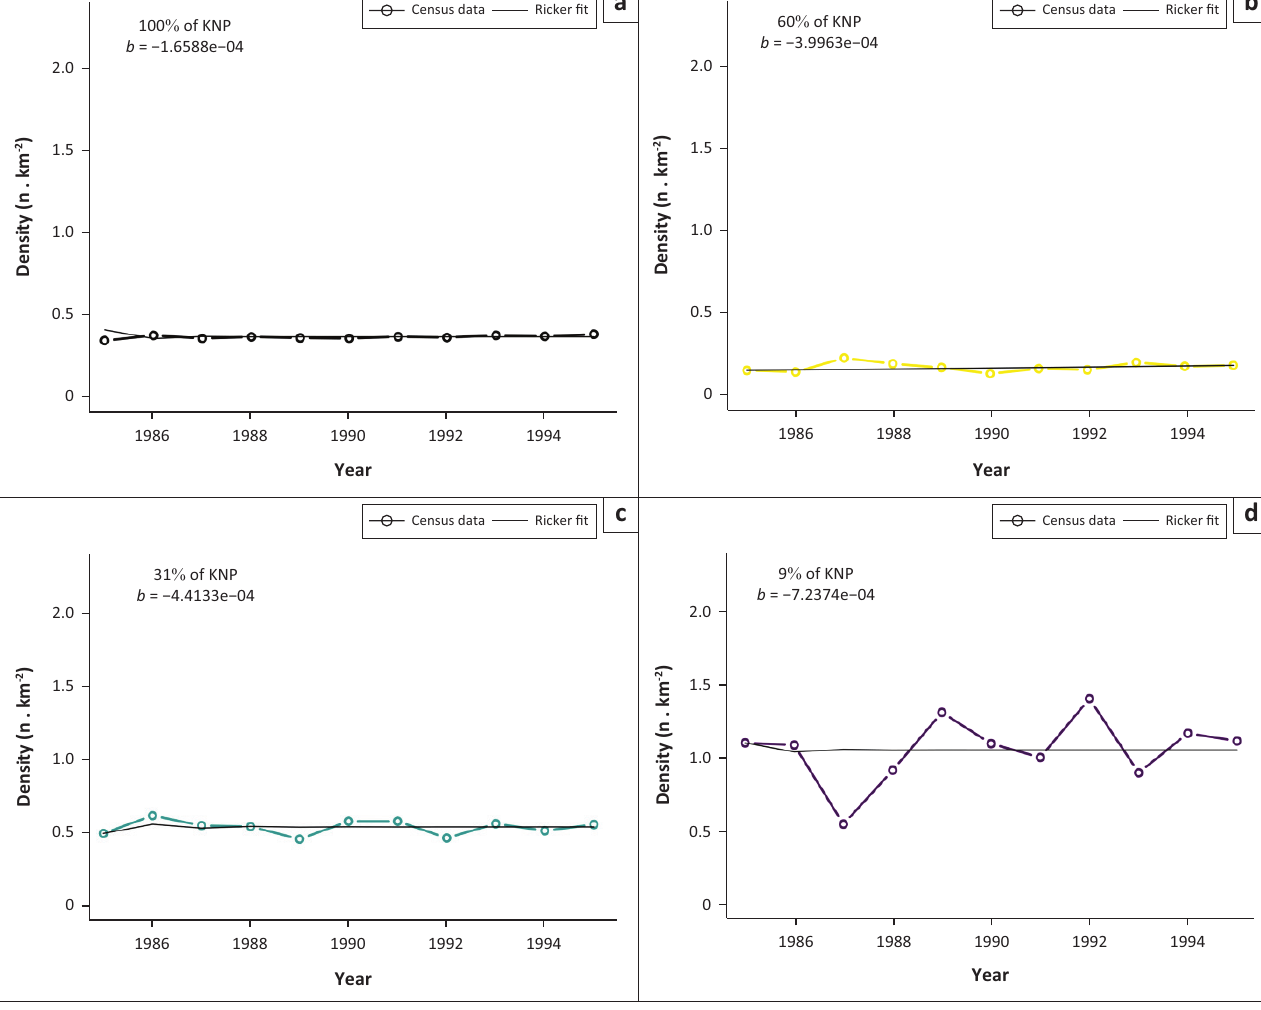
FIGURE 1-A1: (a) Overall, (b) peripheral zone, (c) semi-peripheral zone and (d) core Zone. Deterministic component of Ricker growth models (Eqn 3) fitted to time-series of elephant population in Kruger National Park during the period of regular culling (1985–2012) Model parameter estimates in Appendix 1 (Table 2-A1). Models shown for overall population, and separately for three zones in the park having low medium or high long-term average elephant density (denoted as ‘peripheral’, ‘semi-peripheral’ and ‘core’ zones for elephants). Test for negative density-dependent growth reported significant for all the zones, and the population